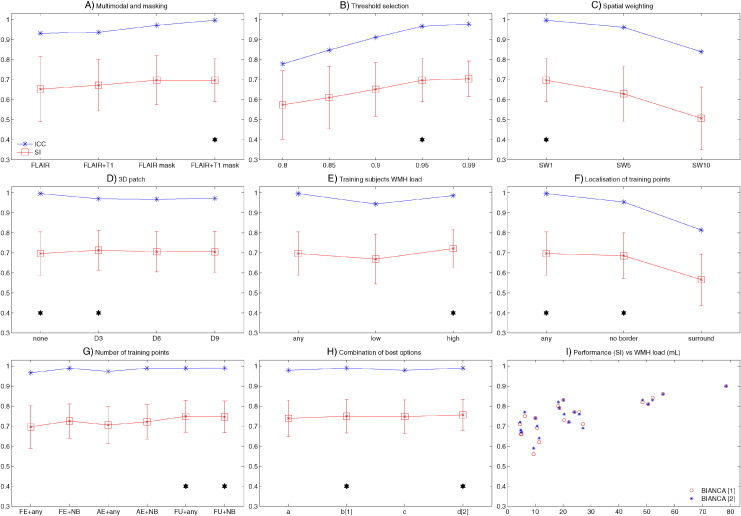
BIANCA optimisation phase I. The plots show the values of the main metrics used to evaluate BIANCA performance using different values (x axis) for the different options (panels A-H. Please refer to the main text and supplementary table S1 for details about the options). The similarity index (SI) is shown in red, with mean value (square marker) and standard deviation (error bars) across subjects. The intra class correlation coefficient (ICC) between the total WMH volume from BIANCA output and manual segmentation is shown in blue. The black stars indicate the value(s) chosen for a specific option. Panel I shows BIANCA performance (SI) for each subject against the WMH load (WMH volume in mL extracted from the manual masks.Legend: FE = Fixed Equal, AE = All Equal, FU = Fixed Unbalanced number of training points; NB = no border. Panel H legend: a = high WMH load training subjects, FU training points, no patch, any location for non-WMH training points, threshold = 0.9, mask applied; b = high WMH load training subjects, FU training points, no patch, NB location for non-WMH training points, threshold = 0.9, mask applied; c = high WMH load training subjects, FU training points, patch D = 3, any location for non-WMH training points, threshold = 0.9, mask applied; d = high WMH load training subjects, FU training points, patch D = 3, NB location for non-WMH training points, threshold = 0.9, mask applied. [1] and [2] = best options chosen.